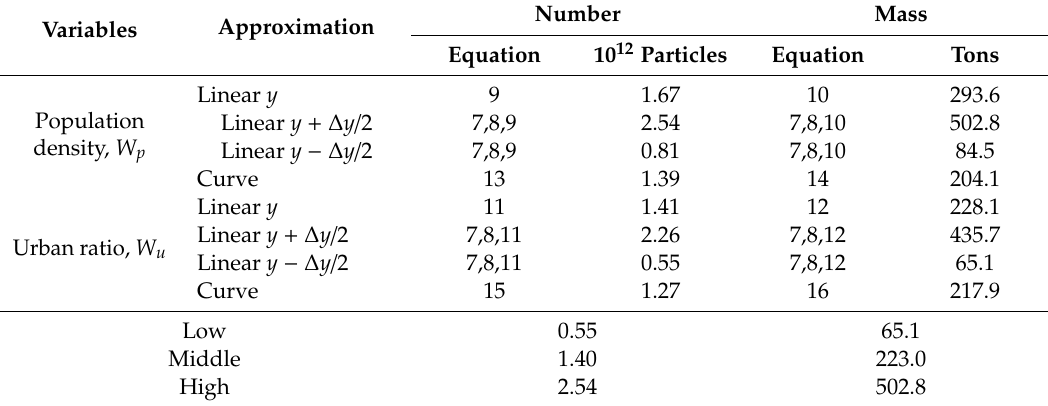
Table 2. Annual inputs of MicP numbers and masses from land to the sea in Japan, obtained using linear approximations of y ± ∆ y /2 (confidence interval: 95%) obtained from raw data, and curves approximated for moving average